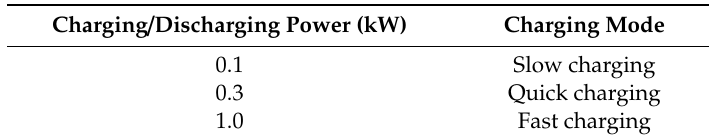
Table 3. EV charging